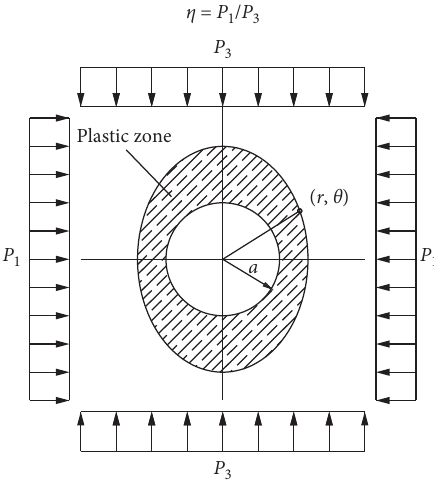
Figure 2: Circular laneway force model in nonuniform stress field. a : laneway radius; r, θ : polar coordinates of any point on the boundary; P 1 : maximum confining pressure; P 3 : minimum con- fining